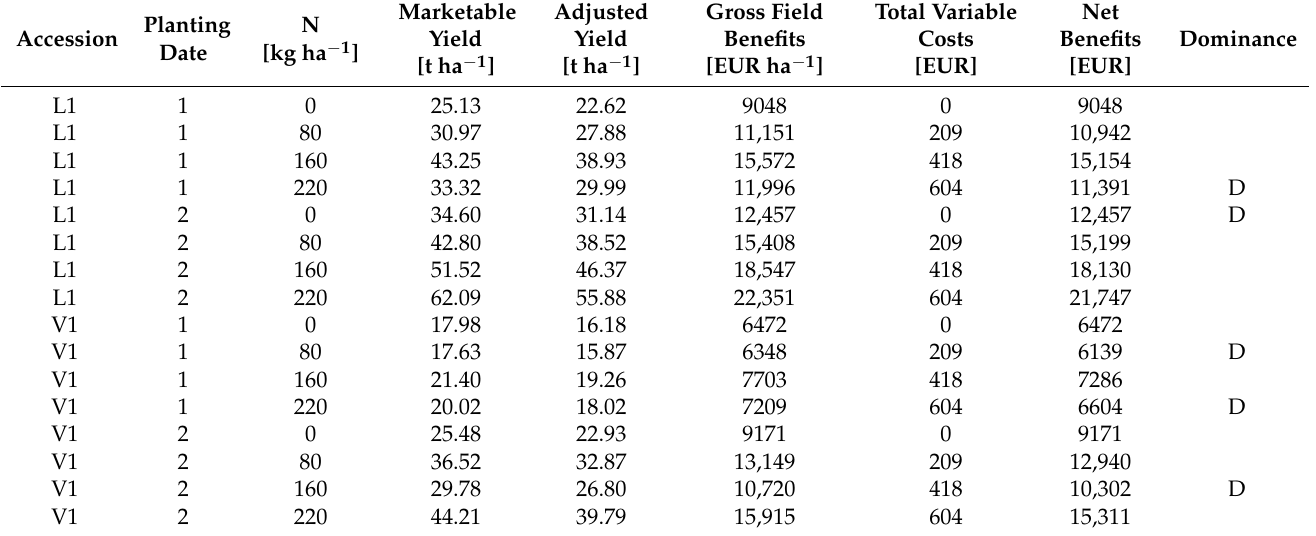
Table 6. Cost–benefit analysis of the two onion accessions expressed as an average of the two agricultural years.